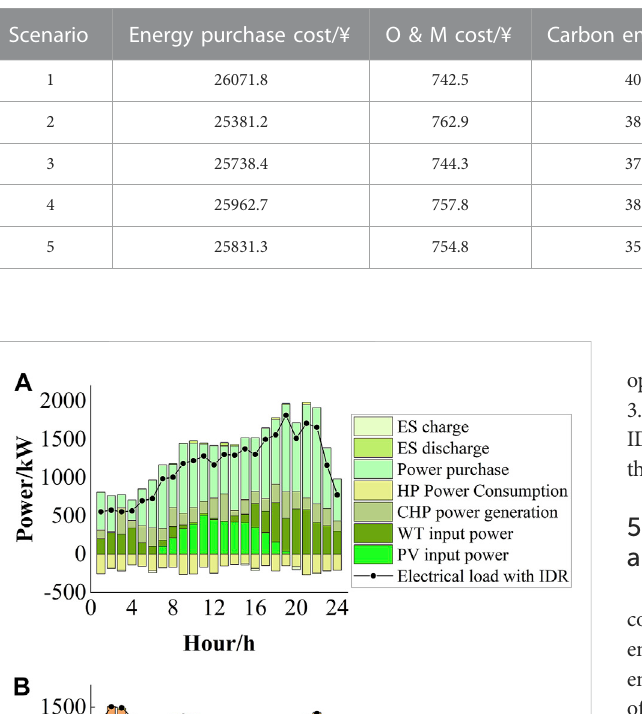
TABLE 6 Comparison of dispatching results under different scenarios.